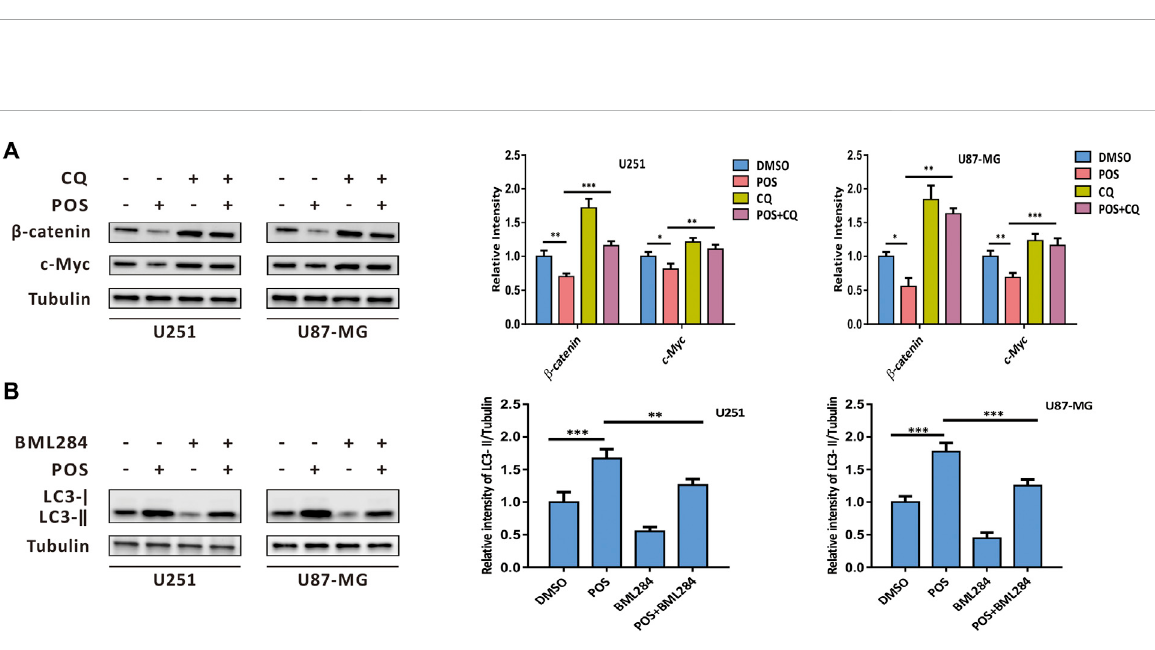
FIGURE 7 POS-induced autophagy intersects with the Wnt/ β -catenin signaling pathway. (A) Expression levels of β -catenin and c-Myc were detected by western blotting after the cells were treated with or without POS in the presence or absence of CQ. (B) Expression levels of LC3 were measured by western blotting after the cells were treated with or without POS in the presence or absence of